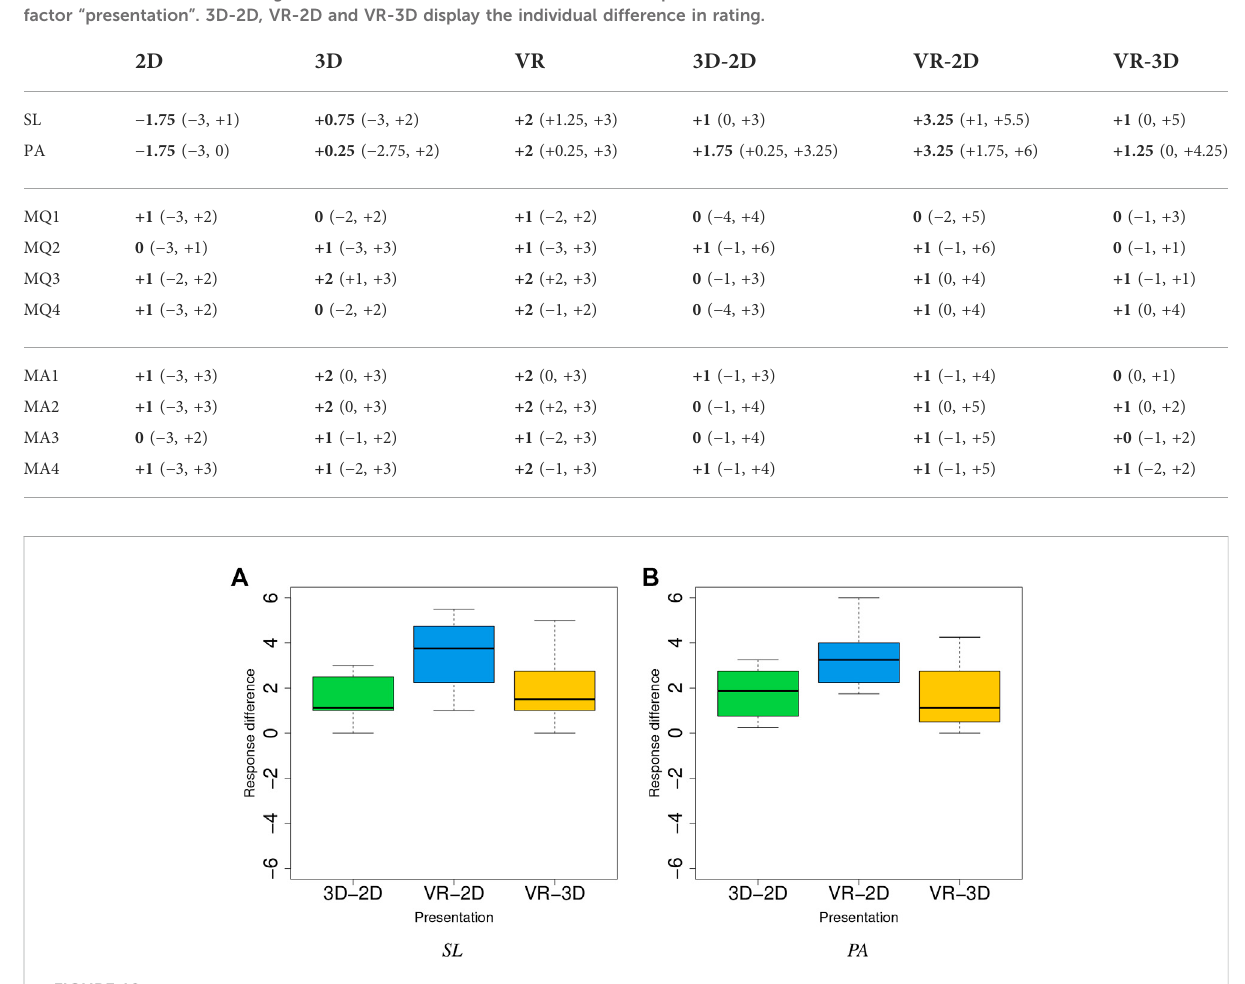
FIGURE 10 Distributions of difference in within-subjects ratings of the SL (A) and PA scale (B)